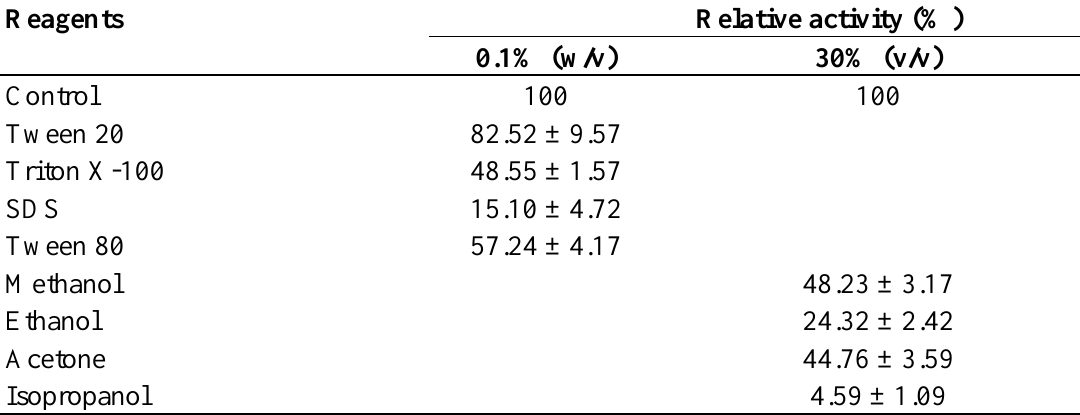
Table 3. Influence of detergents and organic solvents on the recombinant lipase activity a